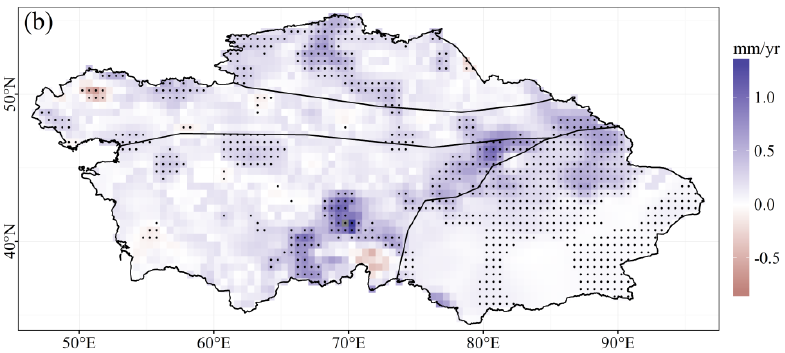
Figure 8. Spatial trends in winter precipitation (mm/year) over Central Asia and four subregions from 1960–2013.